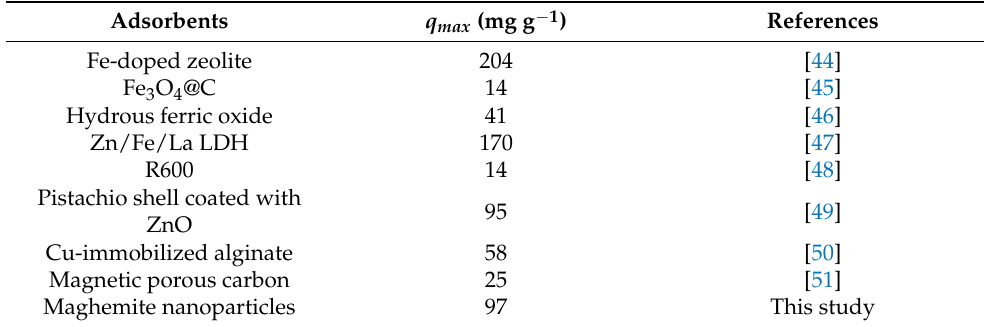
Table 1. Comparison of the maximum adsorption ( q max ) of different adsorbents for the removal of